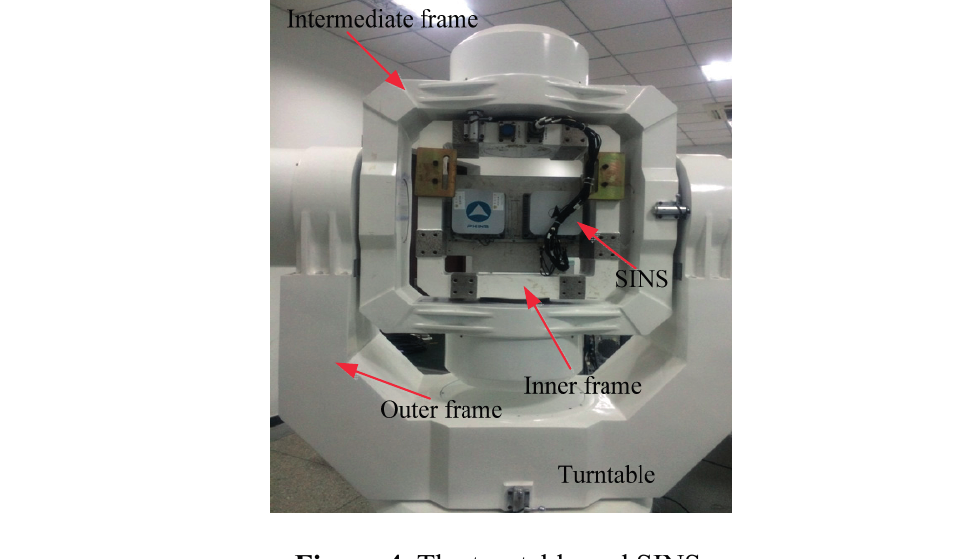
Figure 4. The turntable and SINS. Table 3. Sensor precision of